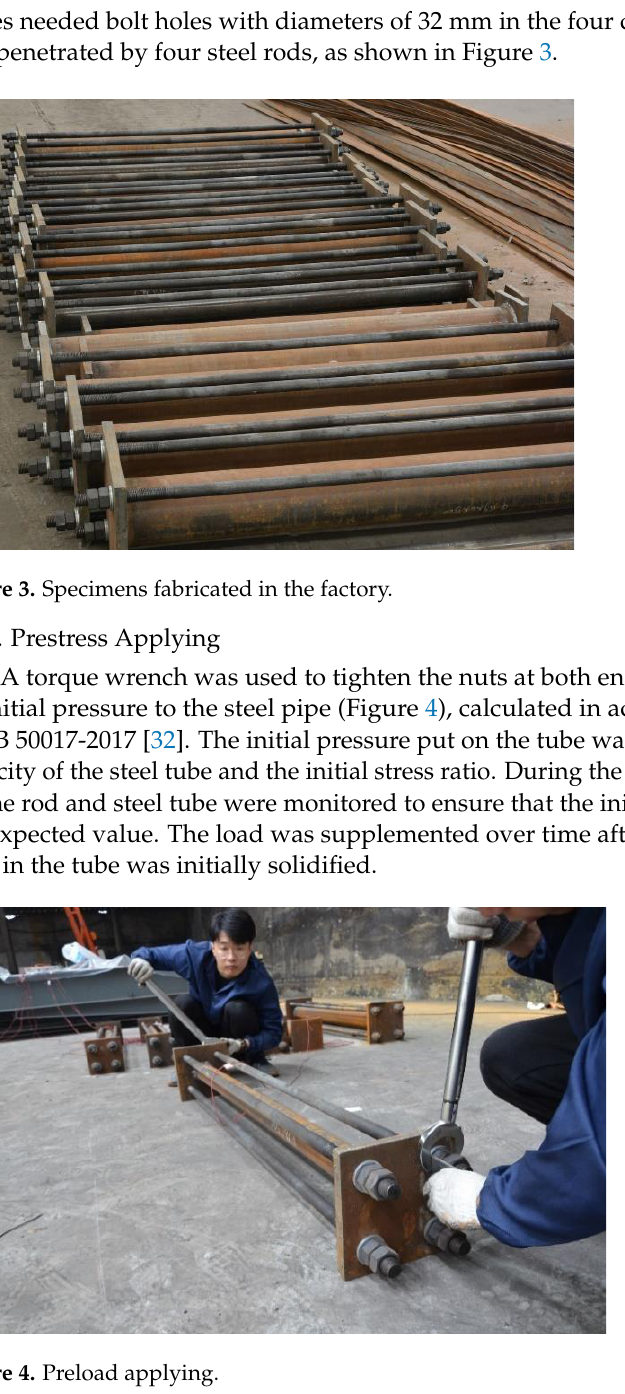
( c ) Figure 5. RPC grouting. ( a ) Trepanning; ( b ) Grouting; ( c ) Strengthening.